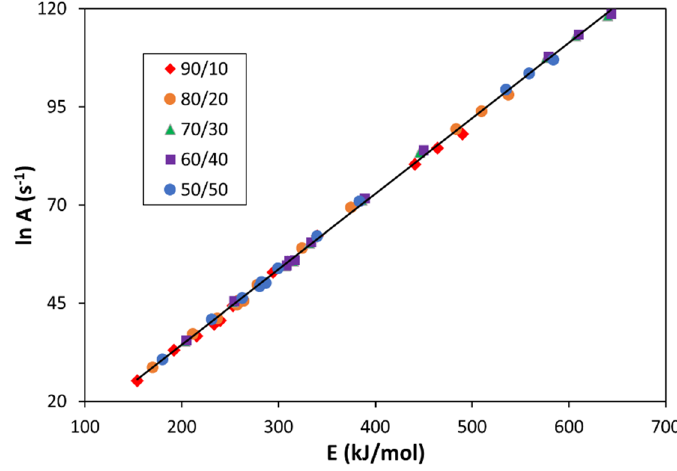
Figure 5. Compensation factor between the frequency factor and activation energy for all the empirical and theoretical kinetic models studied and for all the bioblends analyzed (nominal heating rate = 10 K/min).